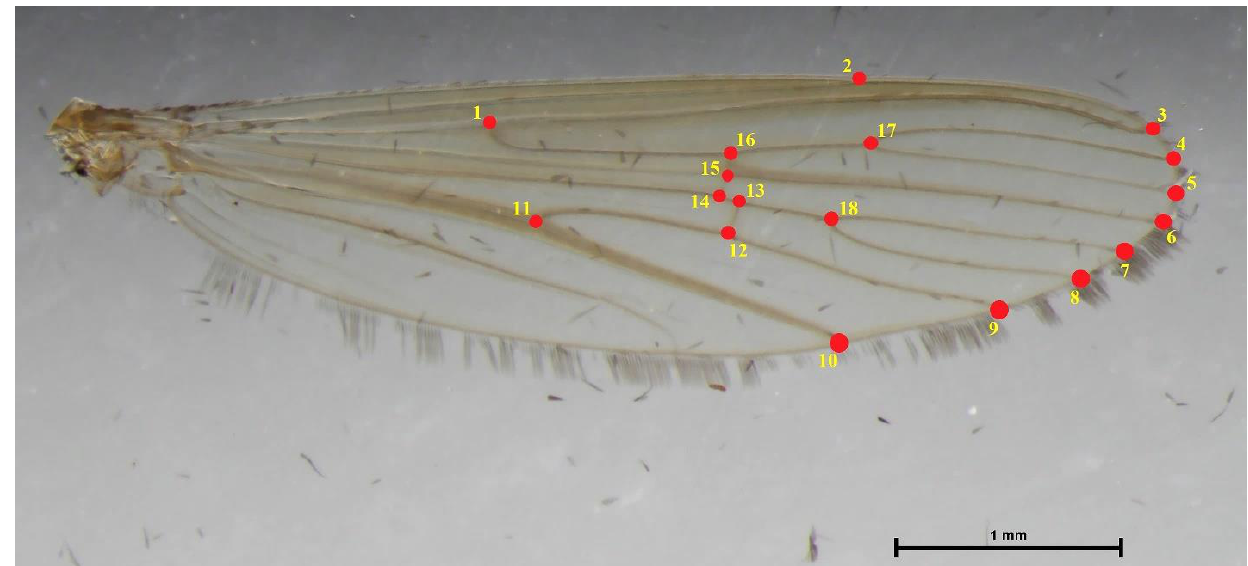
Figure 3. Eighteen landmarks on the wing vein structure of Lutzia mosquito for GM analyses in this study.